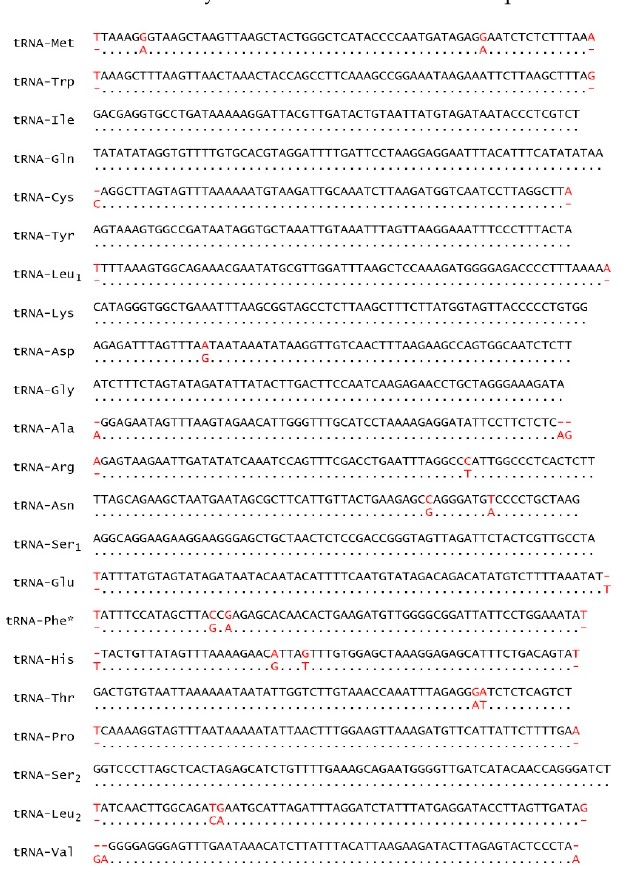
Figure 7. Alignment and comparison of determined tRNA sequences in current study (up) and previous mitochondrial assembly NC_021382 by Zhang et al. [26] (down). Nucleotides in red color display differences between two sequences. ( NC_021382 has been corrected by NCBI staff. The reference sequence is identical to JQ975176.)